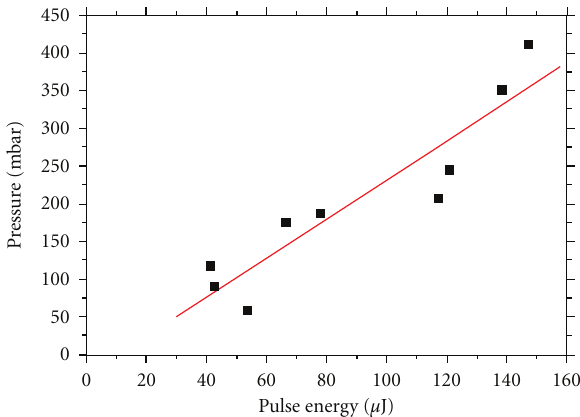
Figure 7: Linear increase in pressure in relation to pulse